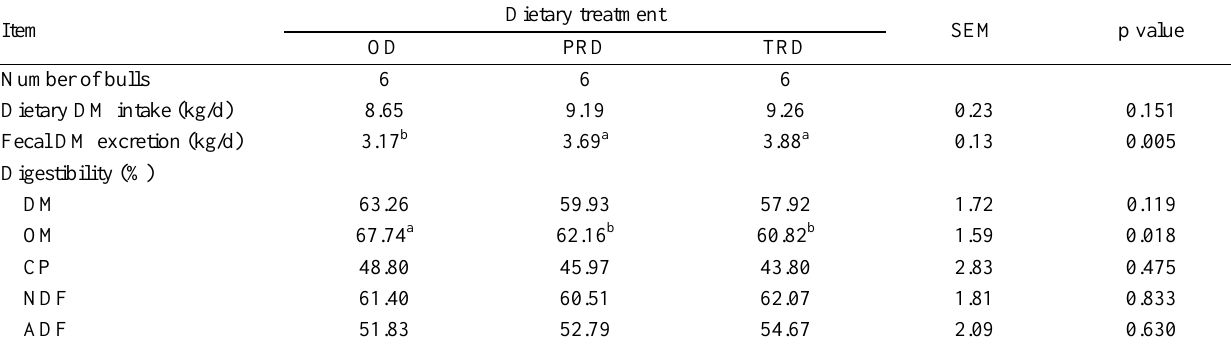
Table 2. Effects of partial or total replacement of maize with alternative feed sources on nutrient digestibility